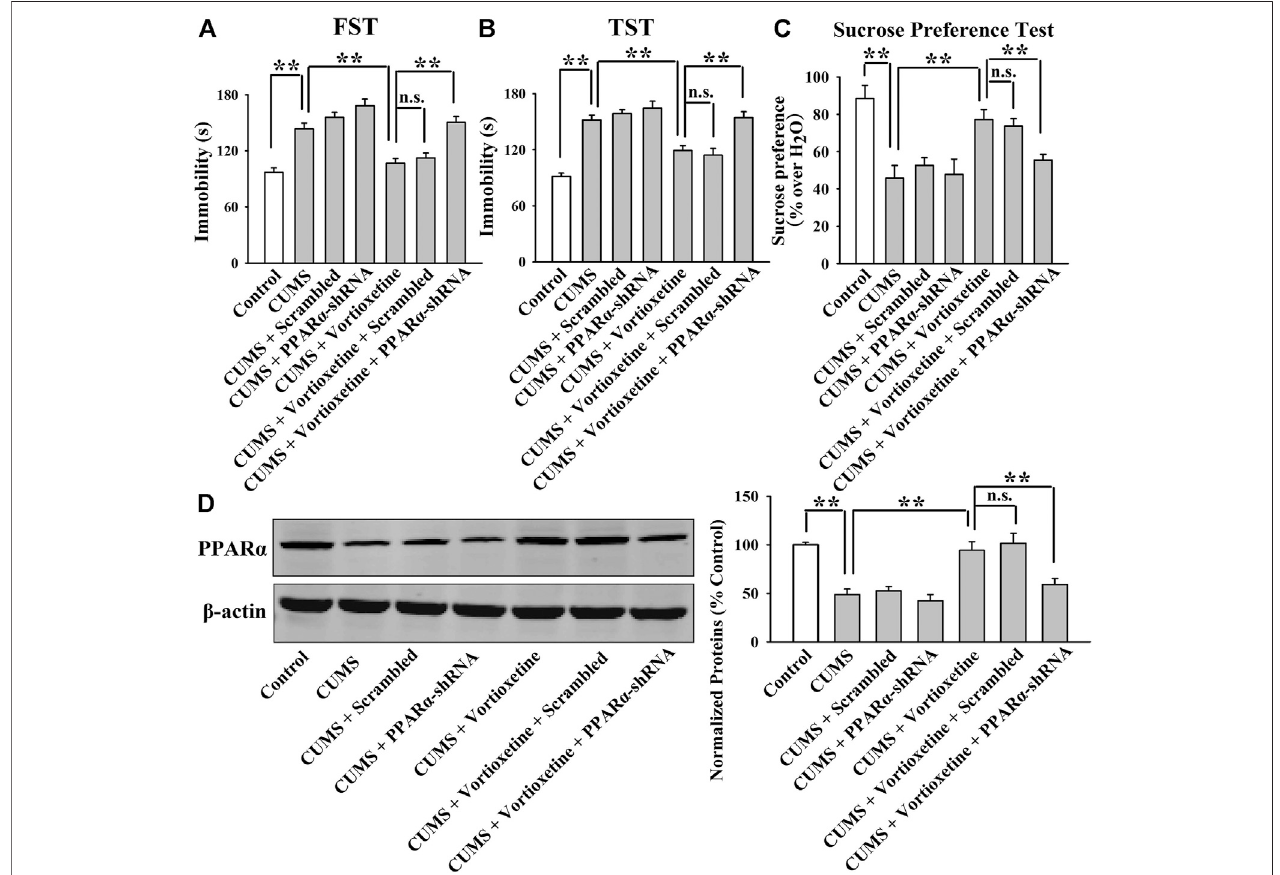
FIGURE 7 | AAV-PPAR α -shRNA completely abolished the antidepressant-like effects of vortioxetine in the CUMS model. (A – C) The (CUMS + vortioxetine + PPAR α -shRNA)-treatedmiceexhibitedsigni fi cantlylongerimmobilityintheFSTandTSTaswellaslowersucrosepreferencethanthe(CUMS+vortioxetine)-treatedand (CUMS + vortioxetine + Scrambled)-treated mice. (D) The (CUMS + vortioxetine + PPAR α -shRNA)-treated mice displayed notably less expression of hippocampal PPAR α than the (CUMS + vortioxetine)-treated and (CUMS + vortioxetine + Scrambled)-treated mice. For (A – C) , n (cid:2) 10 per group; For (D) , n (cid:2) 5 per group. The data are expressed as the means ± S.E.M.; ** p < 0.01; n.s., no signi fi cance. The comparisons were made by two-way ANOVA followed by Bonferroni ’ s test.